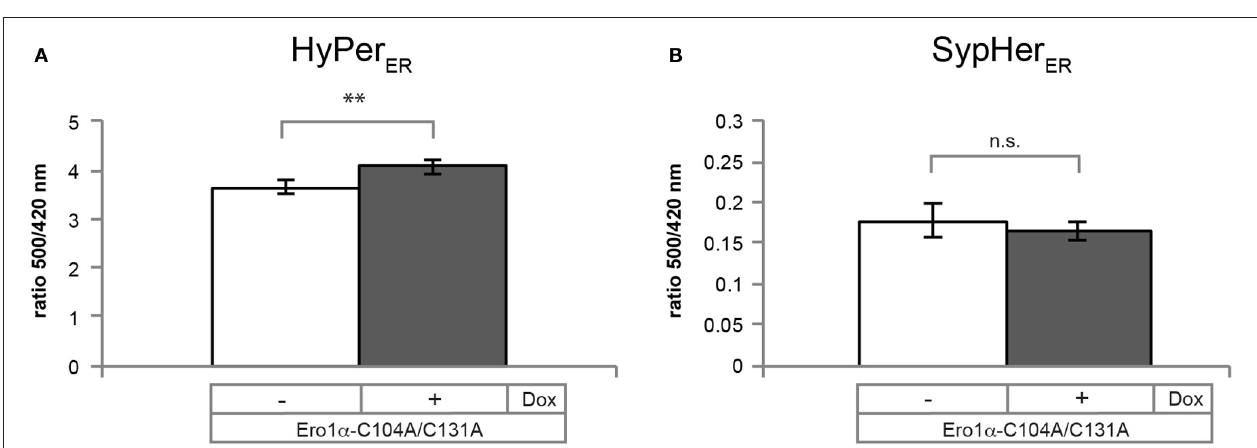
FIGURE 8 | Ero1 α -C104A/C131A-inducedchangesinthe500/420nmratios of HyPer ER and SypHer ER . Plotted are the ratios of the 500 and 420nm peak amplitudes of the steady state spectra of HyPer ER (A) or SypHer ER (B) , which